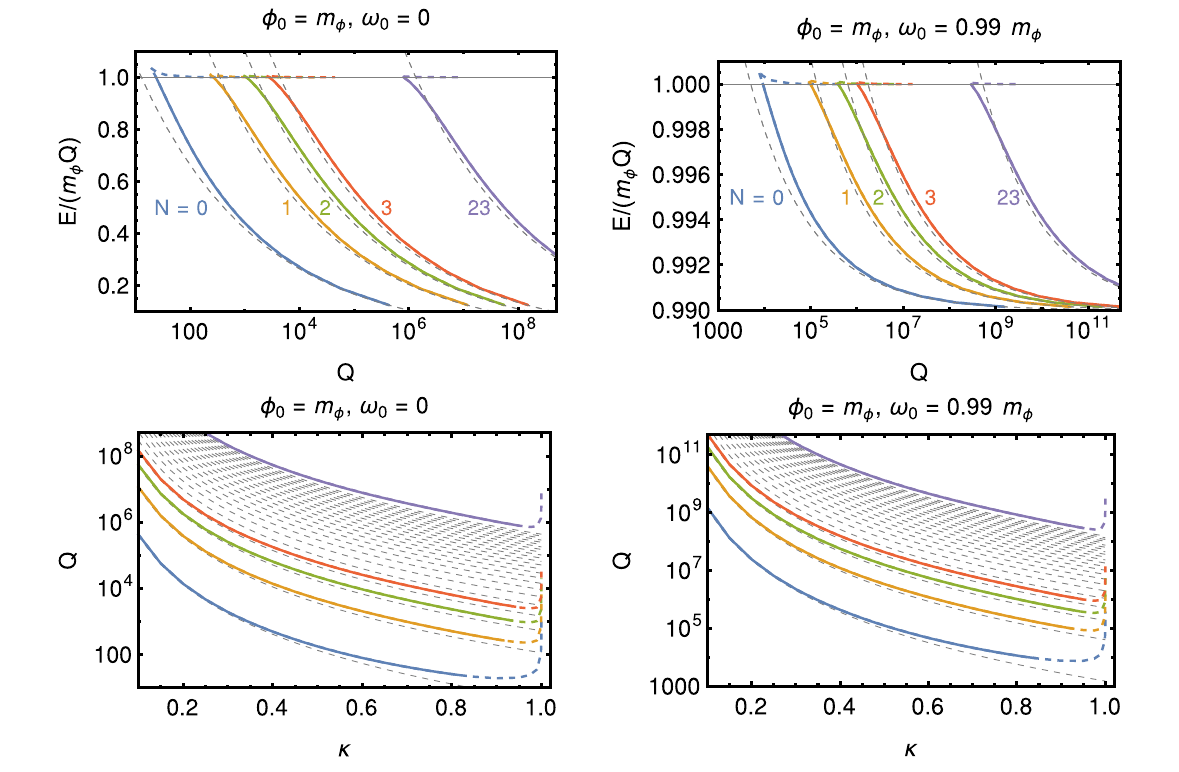
vs. κ for the same examples. The gray dashed lines show the small- κ prediction Q ∝ ( 2 N + 1 ) 3 /κ 6 prediction from Eq. (60) for N = 0 to N = 23 to illustrate the density of states. Note that we arbitrarily stop at N =